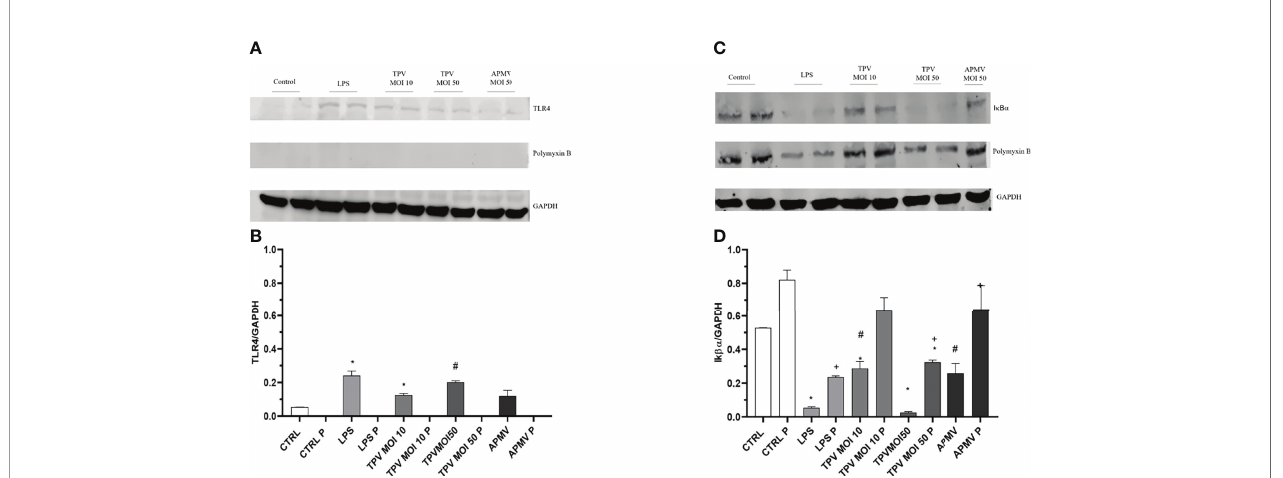
FIGURE 3 | Pulmonary epithelial cells TLR4 are weakly recruited and the degradation of I k B a was favored by the presence of APMV and TPV, regardless of the MOI used. Polymixin B completely blocks the activation of TLR4 and decreases the degradation of I k B a . (A) Representative immunoblot membrane that shows the weak TLR4 protein expression in A549 cells exposed for 30 minutes to DMEN, APMV (MOI 50), TPV (MOI 10 or 50), LPS (100 ng/ml), pretreated or not with polymyxin B (50 µg/m) for 1 hour. To con fi rm a similar gel load, the membranes were subjected to an anti-GAPDH antibody for two hours. (B) Graphic created using the ImageJ processing software the quanti fi cation levels of protein expression were made. The data was evaluated as a ratio of the target proteins and the relative expression of the control protein. (C) Representative immunoblot membrane demonstrating the absence of I k B a protein expression in A549 cells exposed for 30 minutes to DMEN, APMV (MOI 50), TPV (MOI 10 or 50), LPS (100 ng/ml), pretreated or not with polymyxin B (50 µg/m) for 1 hour. To con fi rm a similar gel load, the membranes were subjected to an anti-GAPDH antibody for two hours. (D) Graphic created using the ImageJ processing software the quanti fi cation levels of protein expression made. Student T test was used to determine the statistical signi fi cance comparing it with the control: p ≤ 0,05 *, p ≤ 0,05 #, p ≤ 0,05 *, p ≤ 0,05 #, p ≤ 0,05